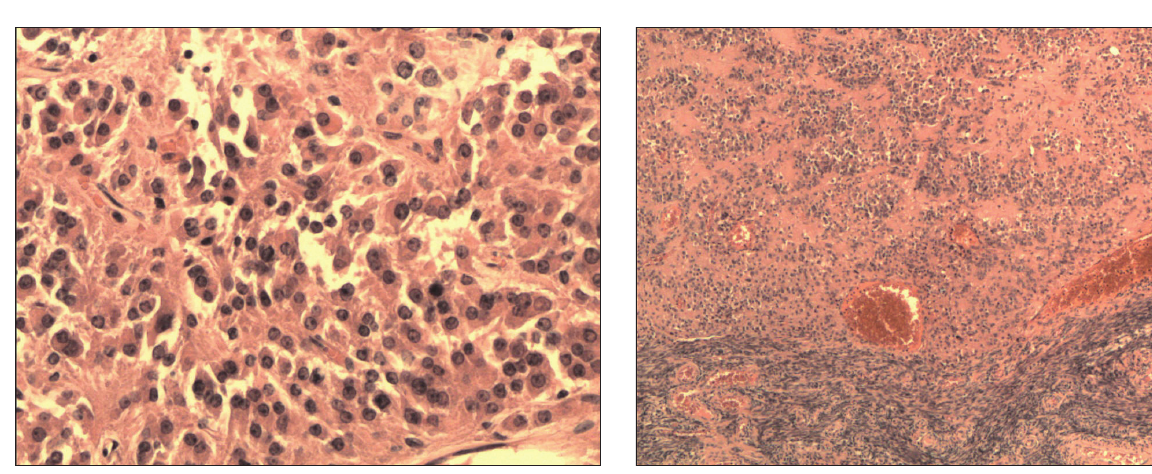
Fig. 2. The adrenal tumor is characterized by solid growth of polygonal cells with an abundant acidophilic cytoplasm. Hematoxyline-eosin, 100x.